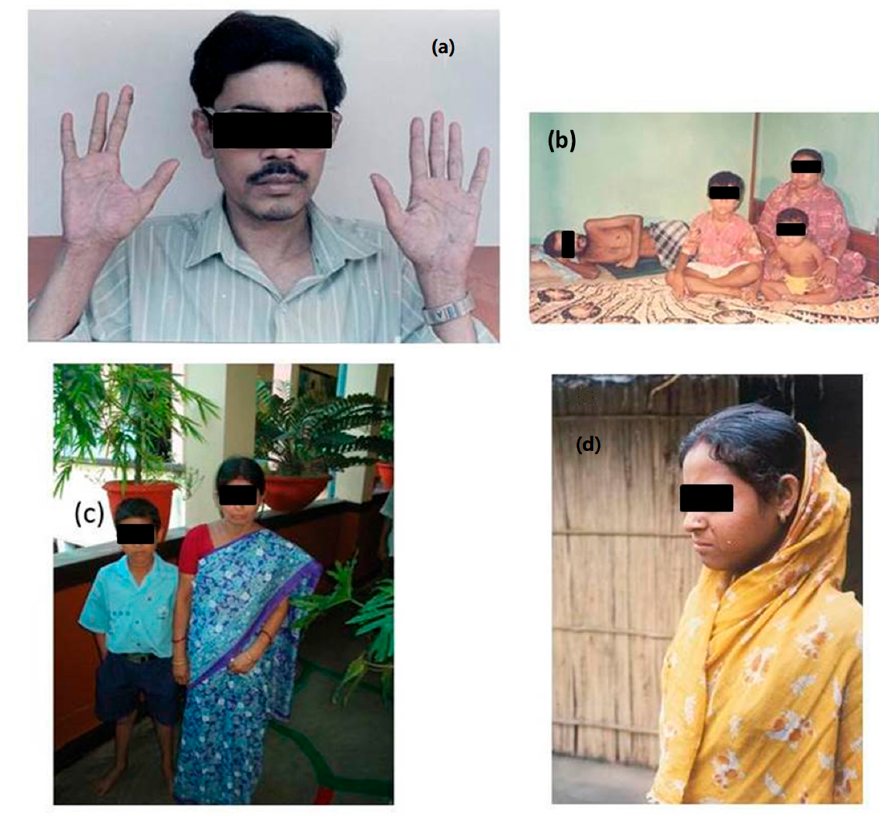
Figure 6. ( a ) Susanta Roy; ( b ) Makhan Pal; ( c ) Bipasha Bhowmik and her son and ( d ) a lady in a village Godagari in Murshidabad.